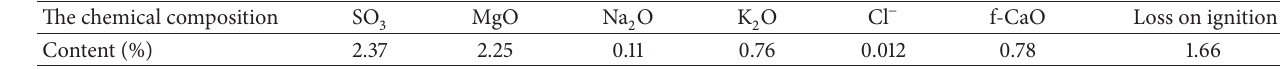
Table 1: The chemical composition of cement.